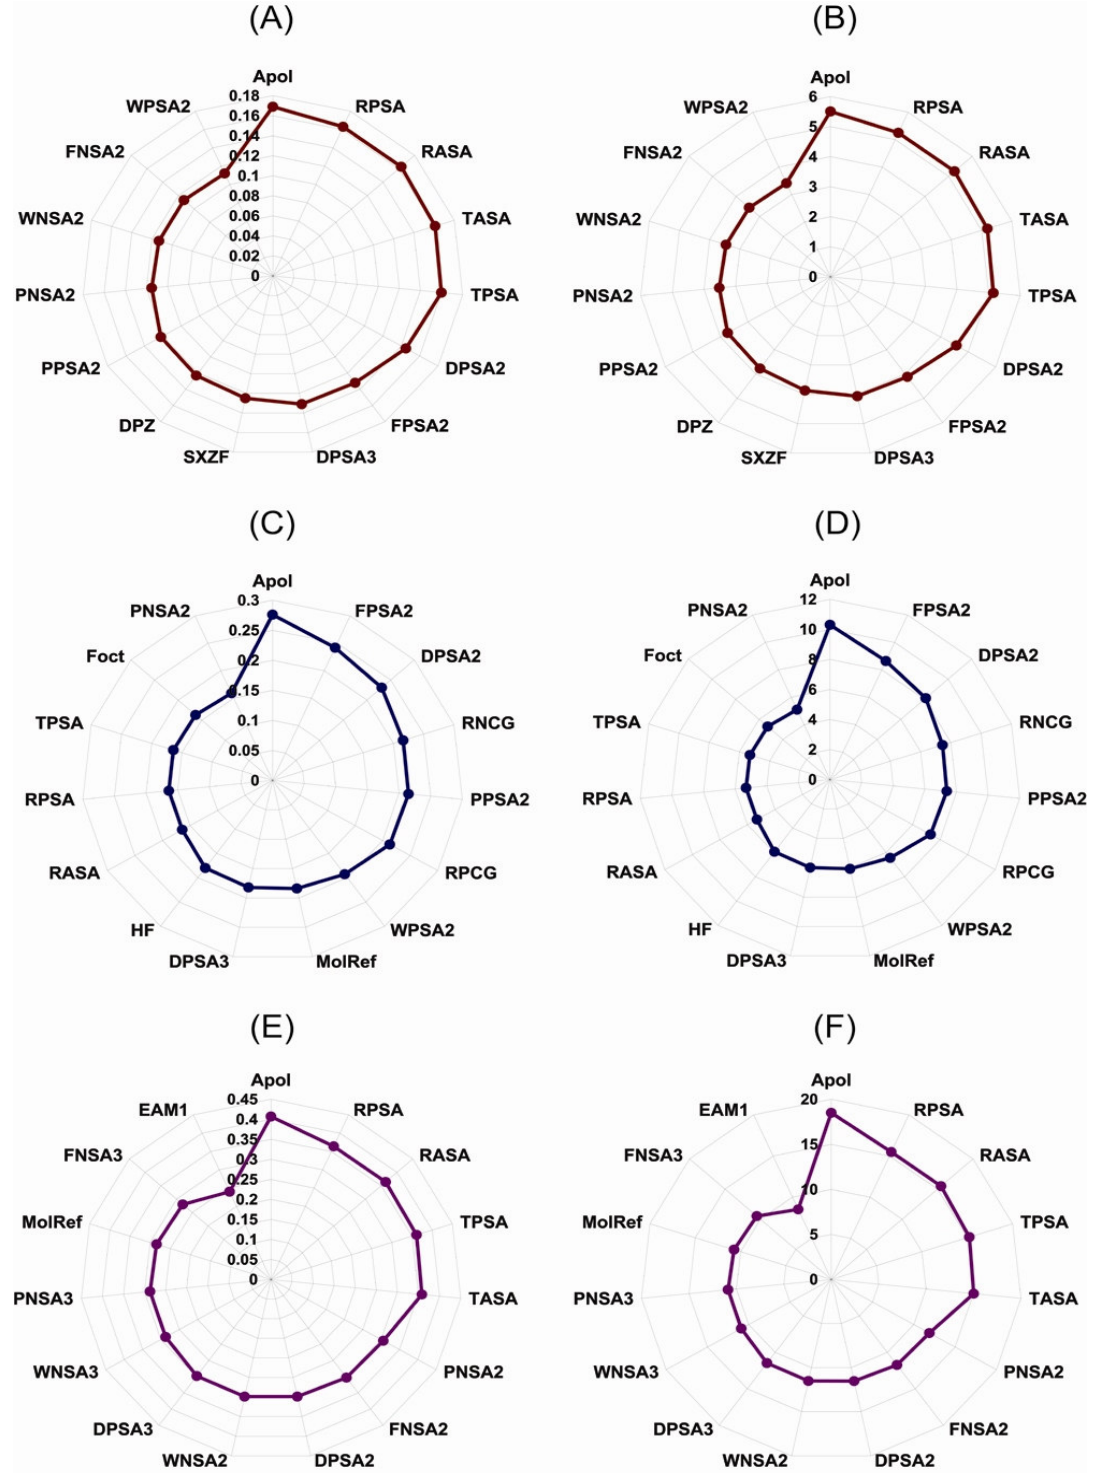
Figure 2. Simple linear regression for (A) r 2 and (B) F-test in MV, (C) r 2 and (D) F-test in MG, and (E) r 2 and (F) F-test in